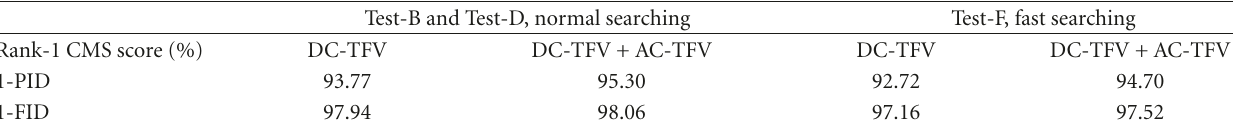
Table 5: Comparison between the results of Test-B and Test-F for the single subarea. The di ff erence between the resulting CMS scores is less than one percent.